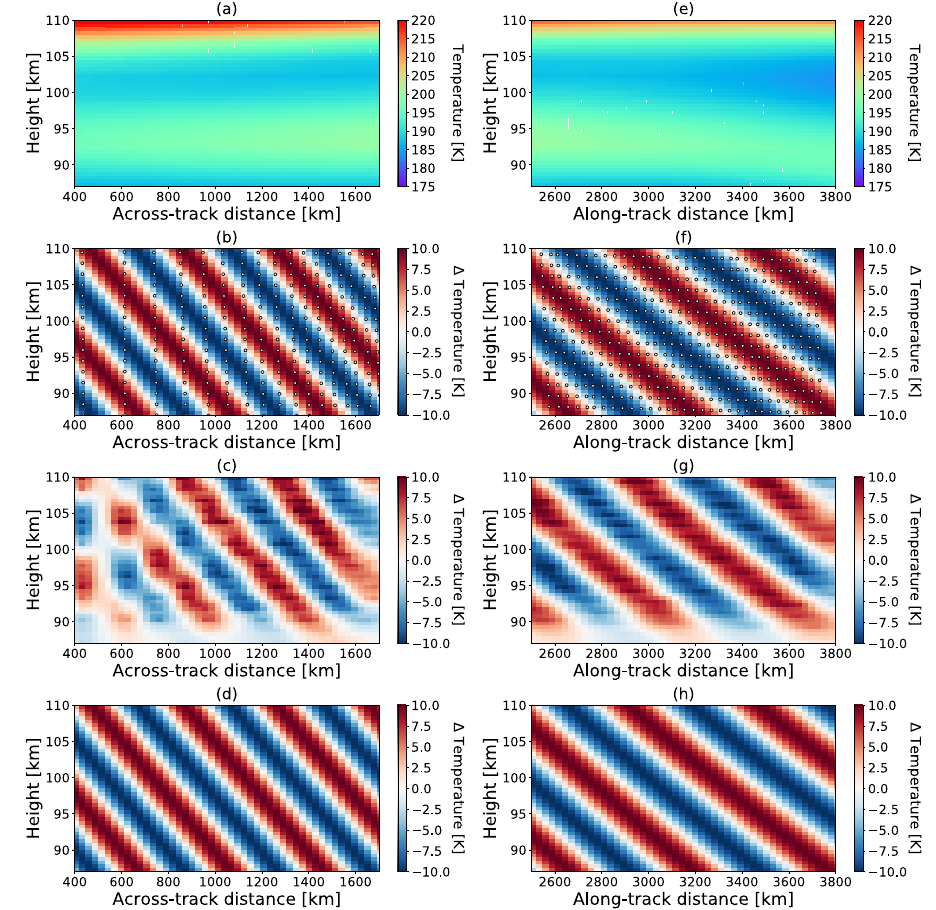
Figure 6. Example of sweep-mode tomographic retrieval a priori, simulated true state, and results using simulated data. The background atmosphere is taken from the HAMMONIA run from 134 to 156 ◦ W and from 4 ◦ S to 19 ◦ N. The panels in the left column are 2-D slices extracted from the 3-D atmospheric volume in the across-track direction, while those in the right column are extracted from the along-track direction. The panels in the first row depict the a priori atmosphere. The panels in the second row show the simulated wave structures, along with the tangent points from individual measurements marked as white circles. The panels in the third row show the retrieved temperature perturbations. The panels in the last row depict the optimized wave structures after best-fit